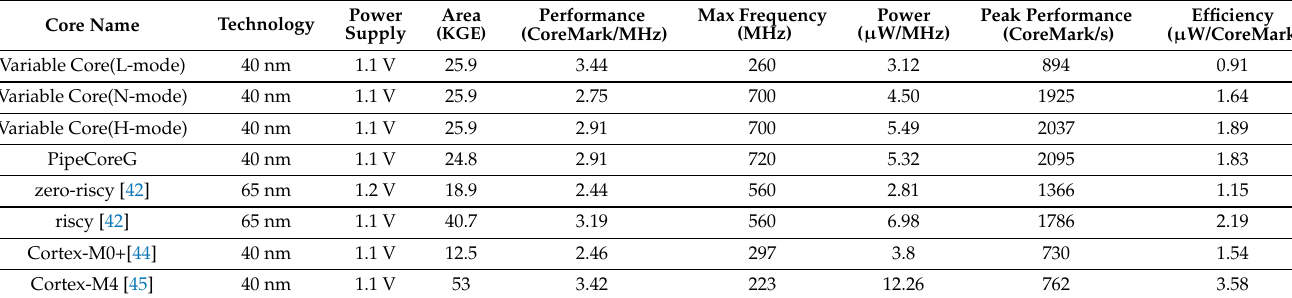
Table 2. Comparison with the state-of-the-art